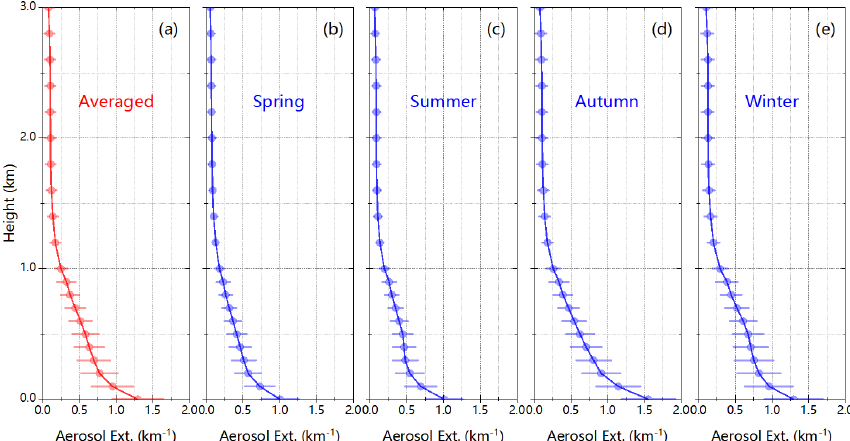
Figure 7. (a) Total-averaged, (b) spring-averaged, (c) summer-averaged, (d) autumn-averaged and (e) winter-averaged aerosol extinction vertical profiles from December 2017 to February 2019 at CAS